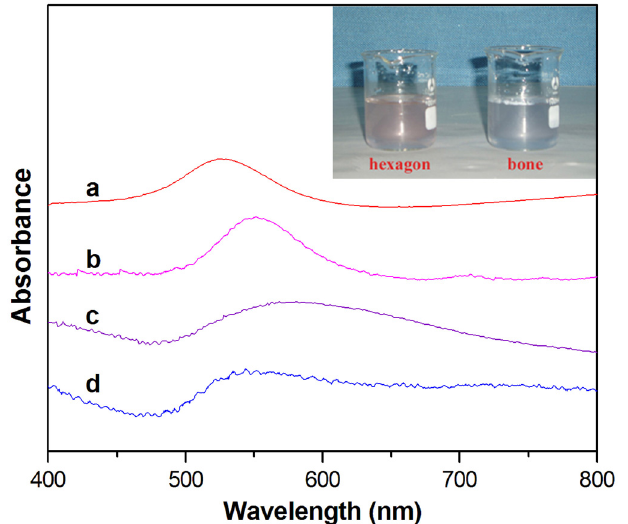
Figure 4. UV-visible absorption spectra of sphere-shaped (a), hexagon-shaped (b), tadpole-shaped (c), and boot-shaped (d) gold nanoparticles taken respectively from their corresponding colloidal solutions, and the inset is digital photos of the reaction mixtures of the nanoparticles with hexagon and boot shapes,